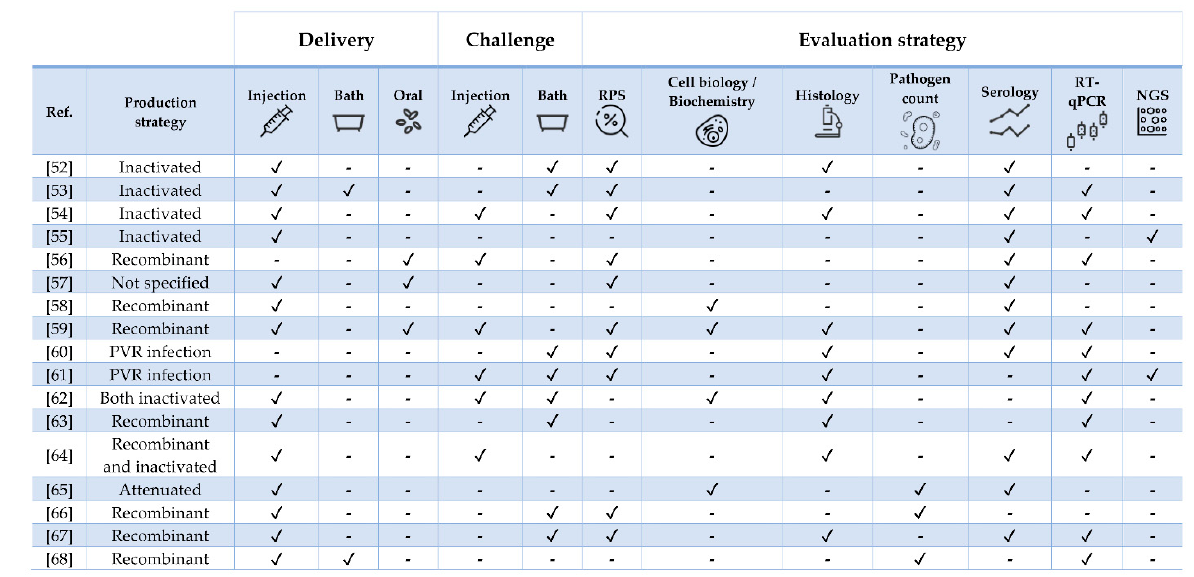
Figure 3. Strategies for vaccine development, administration, and evaluation applied by referenced studies on Atlantic salmon Salmo salar . For readability purposes, the bath and NGS columns also include cohabitation challenges and microarray experiments, respectively.